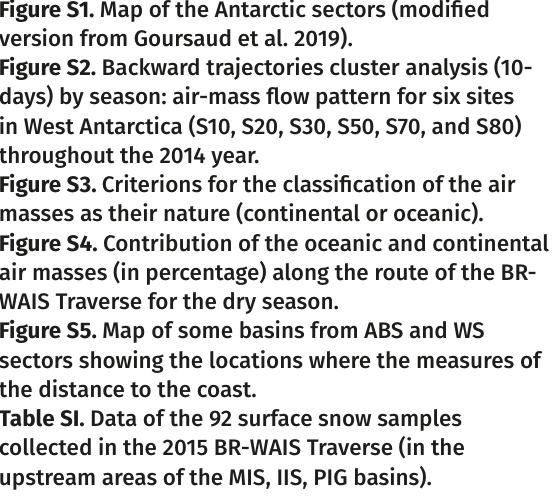
Figure S1. Map of the Antarctic sectors (modified version from Goursaud et al. 2019). Figure S2. Backward trajectories cluster analysis (10- days) by season: air-mass flow pattern for six sites in West Antarctica (S10, S20, S30, S50, S70, and S80) throughout the 2014 year. Figure S3. Criterions for the classification of the air masses as their nature (continental or oceanic). Figure S4. Contribution of the oceanic and continental air masses (in percentage) along the route of the BR- WAIS Traverse for the dry season. Figure S5. Map of some basins from ABS and WS sectors showing the locations where the measures of the distance to the coast. Table SI. Data of the 92 surface snow samples collected in the 2015 BR-WAIS Traverse (in the upstream areas of the MIS, IIS, PIG